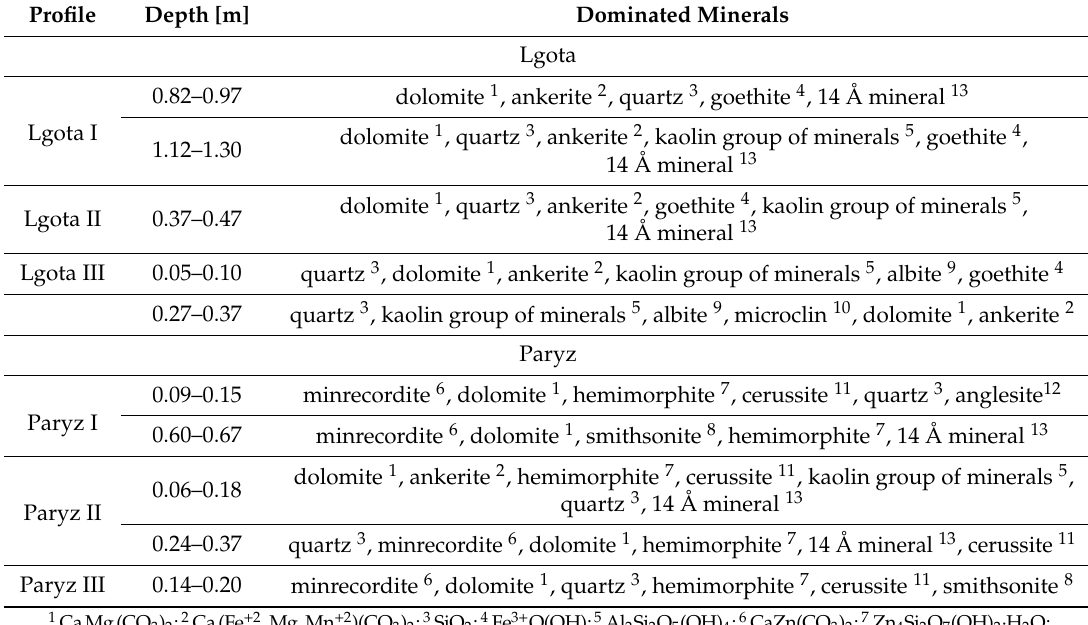
Table 5. Dominant minerals in the Lgota and Paryz